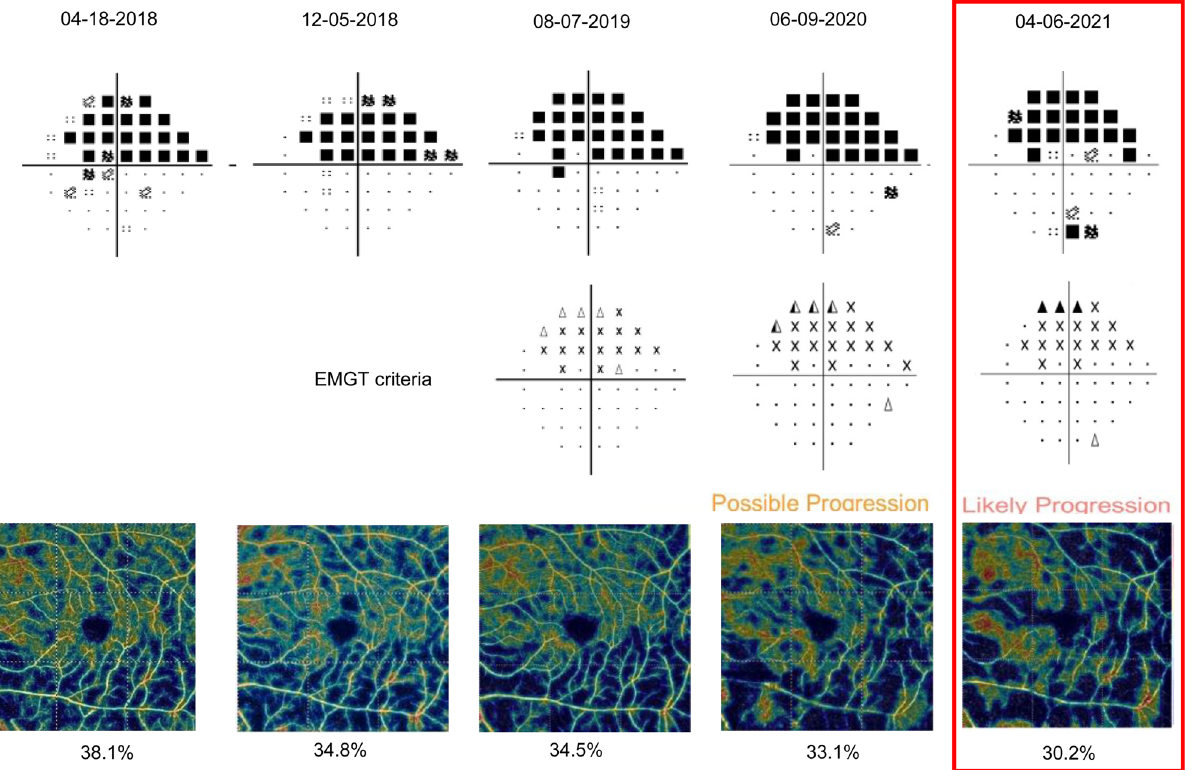
Figure 3. Representative case of a 69-year-old female [baseline visual field (VF) mean deviation (MD), − 11.46 decibels (dB)] showed macular vessel density (mVD) reduction [“two consecutive optical coherence tomography angiography (OCTA) showed mVD reduction the tolerance limit (4.96%) compared to baseline ≥ mVD”] compared to baseline mVD and significant VF progression (“likely progression”) on April 6, 2021. dB decibel , EMGT Early Manifest Glaucoma Trial, MD mean deviation, mVD macular vessel density, OCTA optical coherence tomography angiography, VF visual